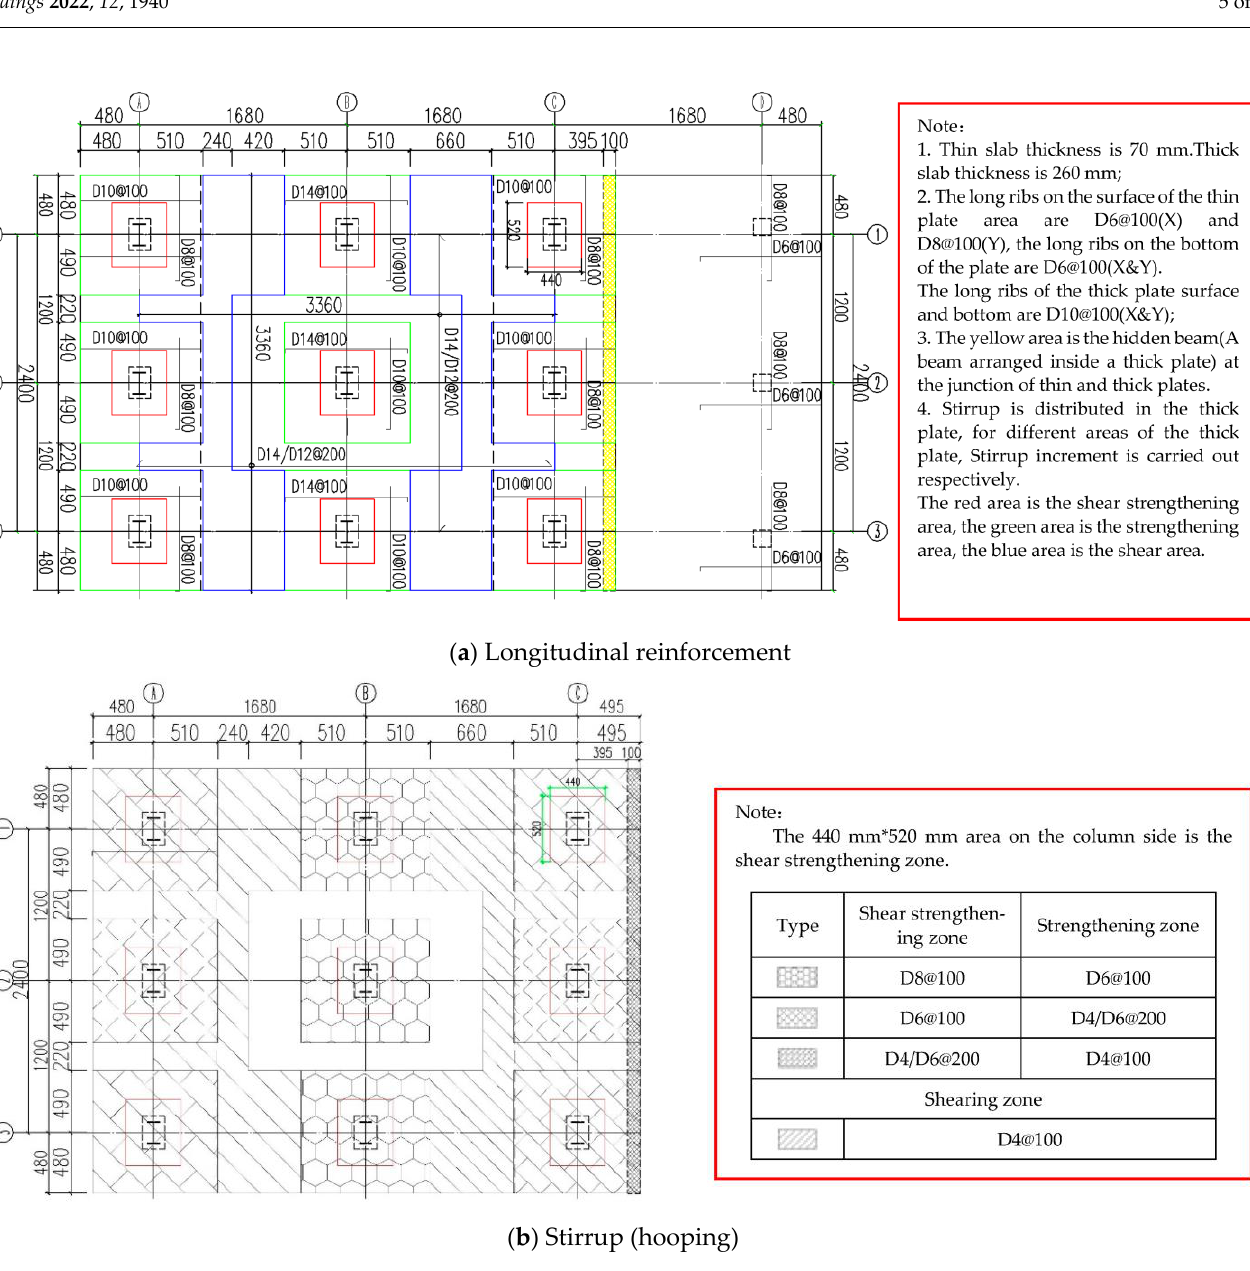
Figure 5. Transfer plate reinforcement.